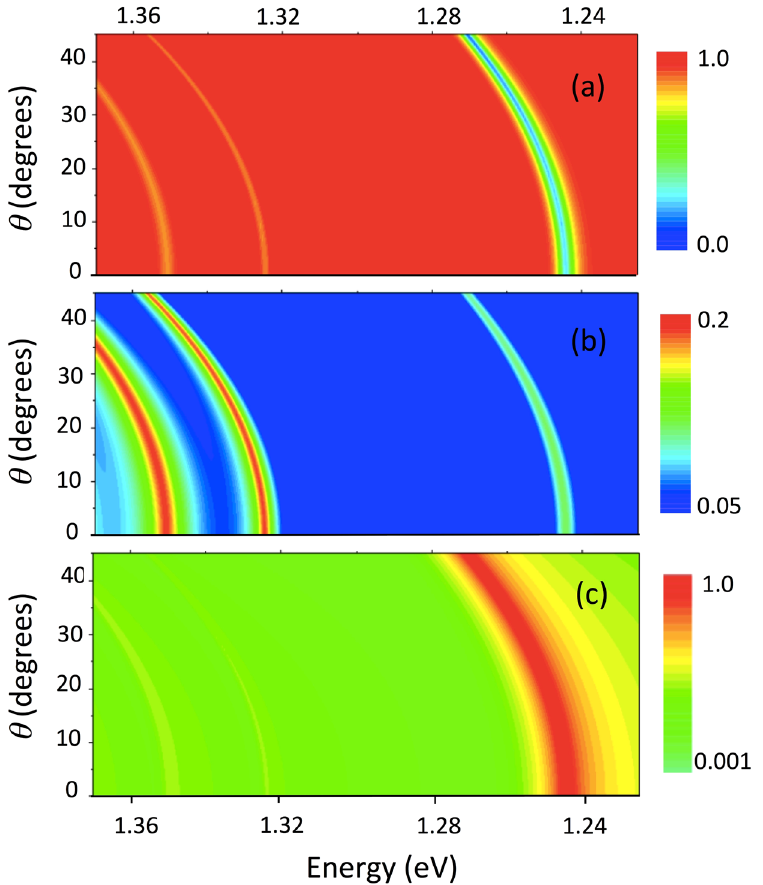
Figure 3. Calculated dependence of reflection ( a ), transmission ( b ) and absorption ( c ) spectra on angle and frequency of emission. Dependences on ( b ) and ( c ) are shown in logarithmic